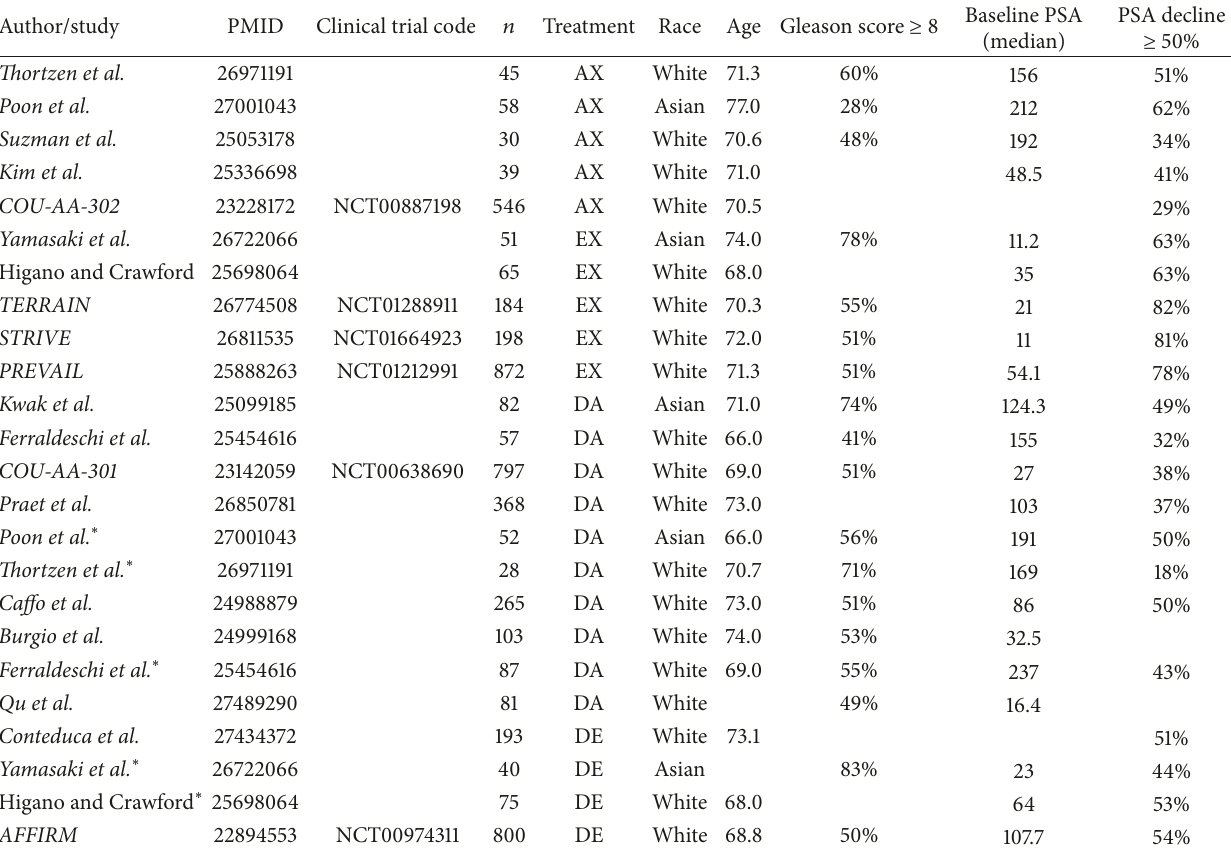
Table 1: All studies included in